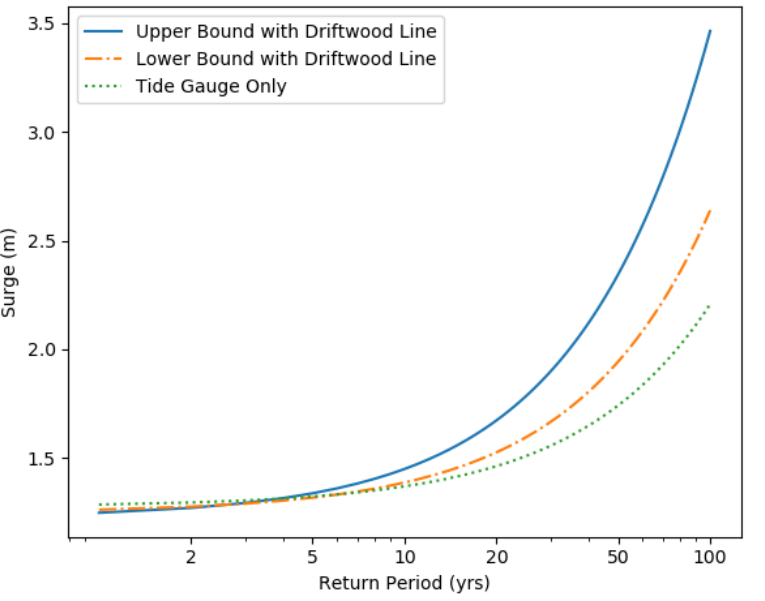
Figure 5. GPD fit to the peak water-level residuals with and without (baseline) different possible storm surge magnitudes associated with the 1944 and 1970 events, inferred from Harper et al.’s [19] driftwood surveys.